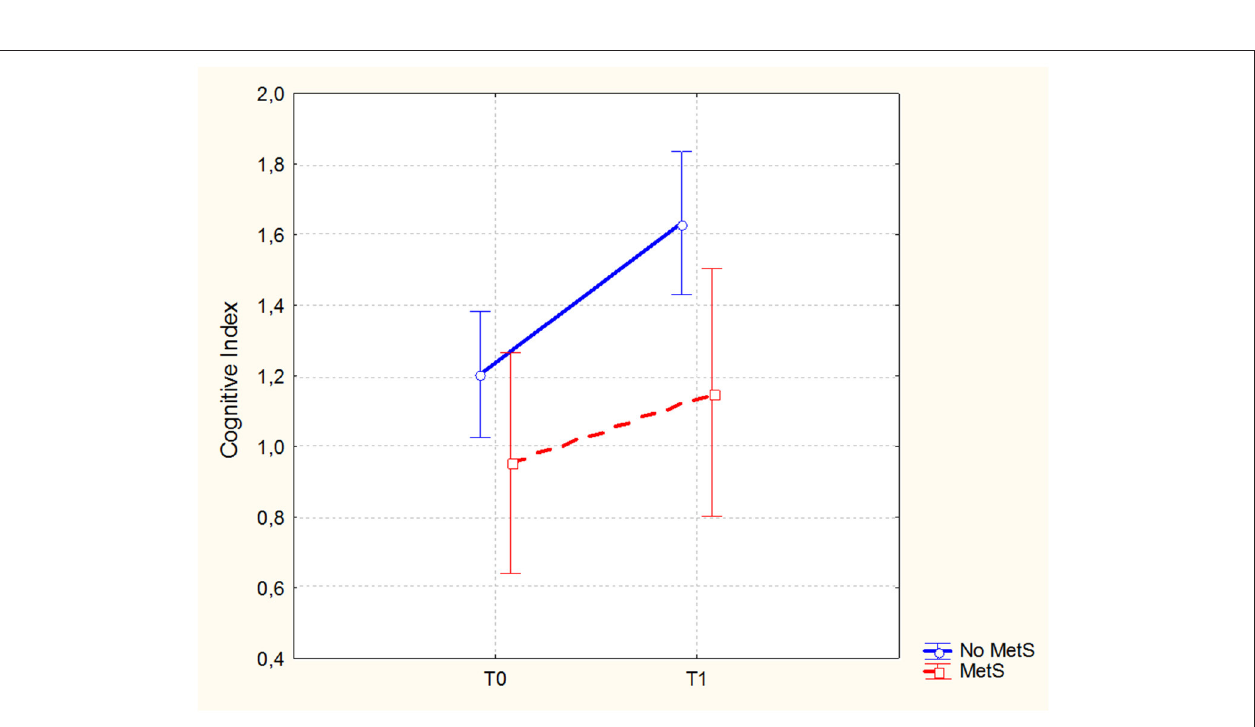
Frontiers in Psychiatry | www.frontiersin.org